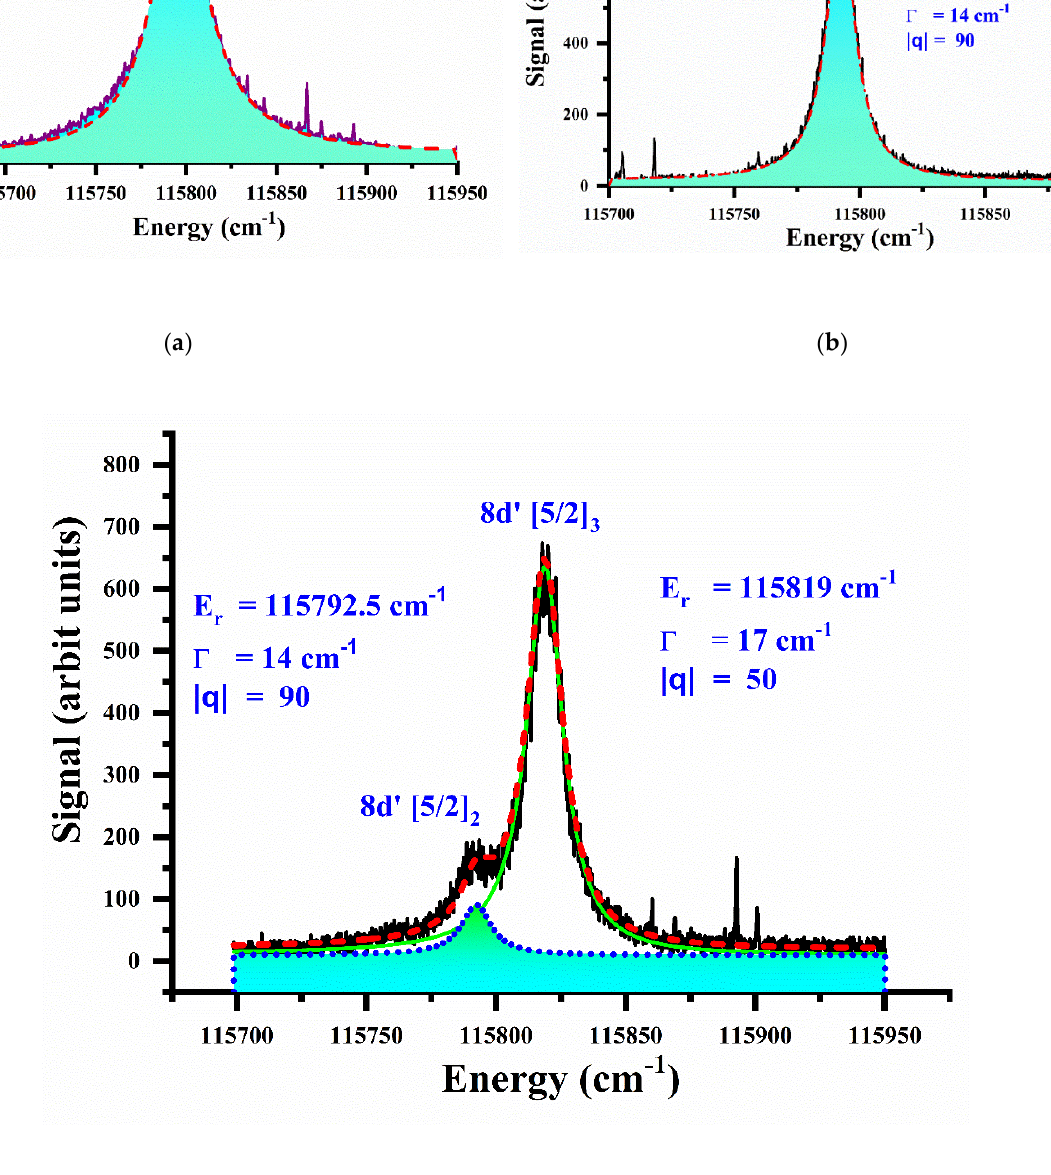
Figure 14. ( a ). The 5p 5 8d’ [3/2] 2 autoionizing resonances in krypton excited from the 4p 5 5p’ [1/2] 1 intermediate level in krypton. ( b ). The 5p 5 8d’ [5/2] 2 autoionizing resonances excited from the 4p 5 5p’ [3/2] 1 intermediate level in krypton. ( c ). The 5p 5 8d’ [5/2] 2 and 5p 5 8d’ [5/2] 3 autoionizing resonances excited from the 4p 5 5p’ [5/2] 2 intermediate level in krypton.